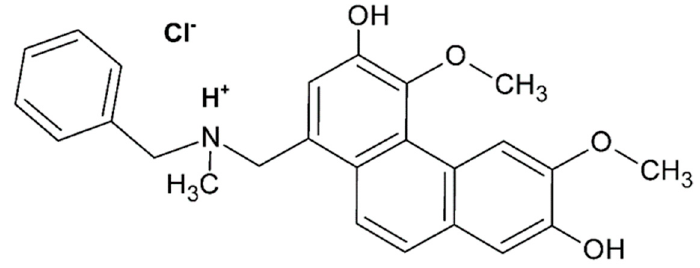
Figure 7. Chemical structures of N -benzylsecoboldine (BSB) hydrochloride [87].